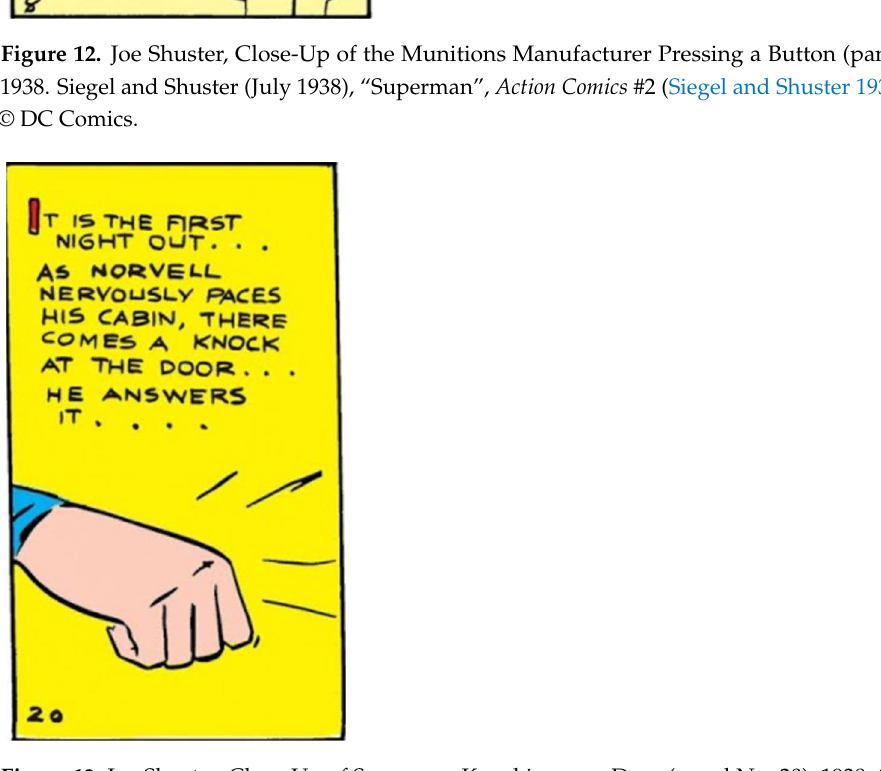
Figure 14. Joe Shuster, Close-Up of a Surprised Man (panel No. 80), 1938. Siegel and Shuster (August 1938), “Superman”, Action Comics #3 (Siegel and Shuster 1938c, p. 46). © DC Comics. The humorous and comedic aspects of the comics, found in almost all of these ele- ments (close-ups, frightened villains, Superman’s approach to these villains, etc.), was partially influenced by the earlier comic strips that appeared in the Sunday newspapers, although Shuster’s style was much less ‘cartoony,’ as he wanted to paint in a more realistic way. Thus, the humor may have made a great first impression on the readers who found Action Comics on the newsstands. Moreover, the emotions, the humor, and the action might also have had a part in engaging readers with the Superman storylines; similar to going to the movies to see their favorite action character, they could find the same features in the pages of this new comic book series. To further extend the notion of the engagement of the audience as a marketing strategy, I now turn to one last visual aspect.